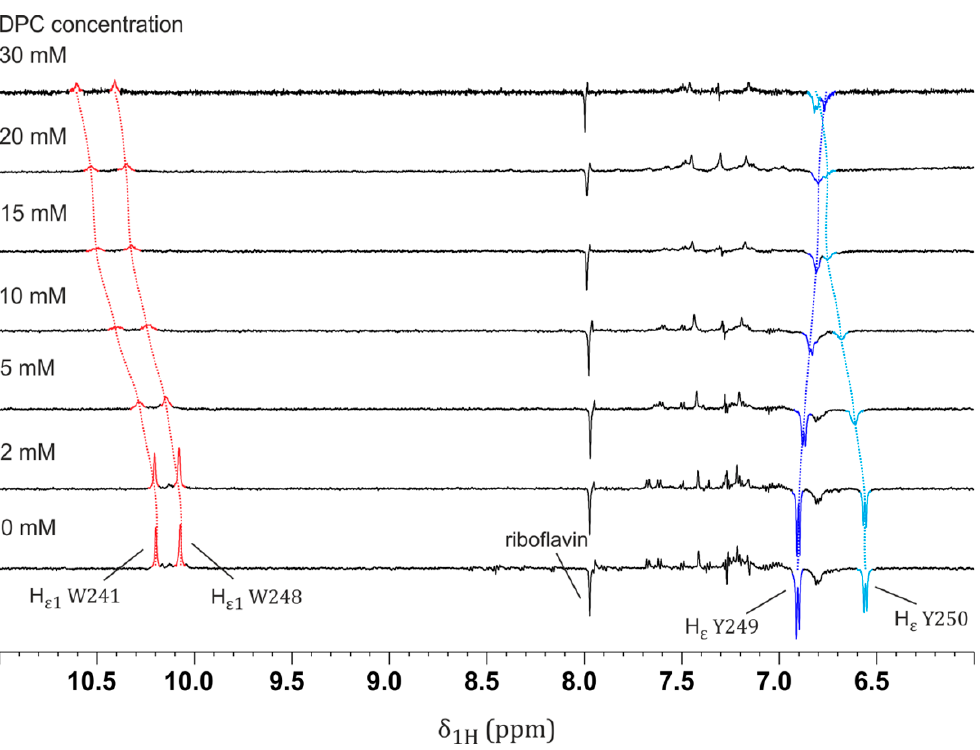
Figure 3. Photo-CIDNP (“light-minus-dark” representation) NMR spectra for DPC micelle titration (from 0 to 30 mM) of 1 mM LytA 239–252 peptide. Method A was followed for the acquisition of NMR experiments (see Section 4). The increase in micelle concentration led to the chemical shifting and line broadening of NMR signals, which are affected by the presence of micelles, especially those corresponding to H ε 1 of W241 and H ε of Y250. Lower CIDNP intensities obtained when increasing micelle concentration were not due to flavin–micelle interactions, since unlike peptide NMR signals, the one corresponding to flavin (8.0 ppm, emissive) is not affected by the presence of micelles at